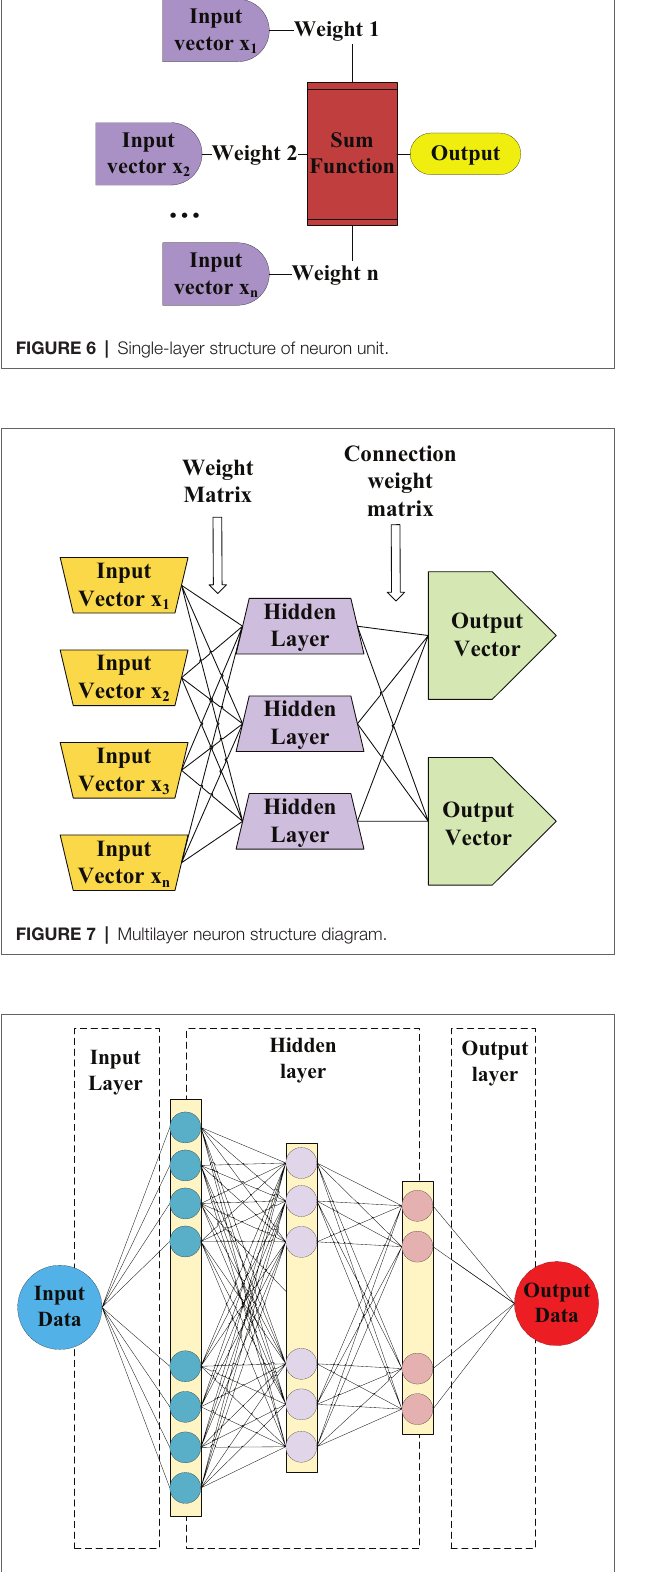
FIGURE 8 | Deep neural network (DNN) structure.